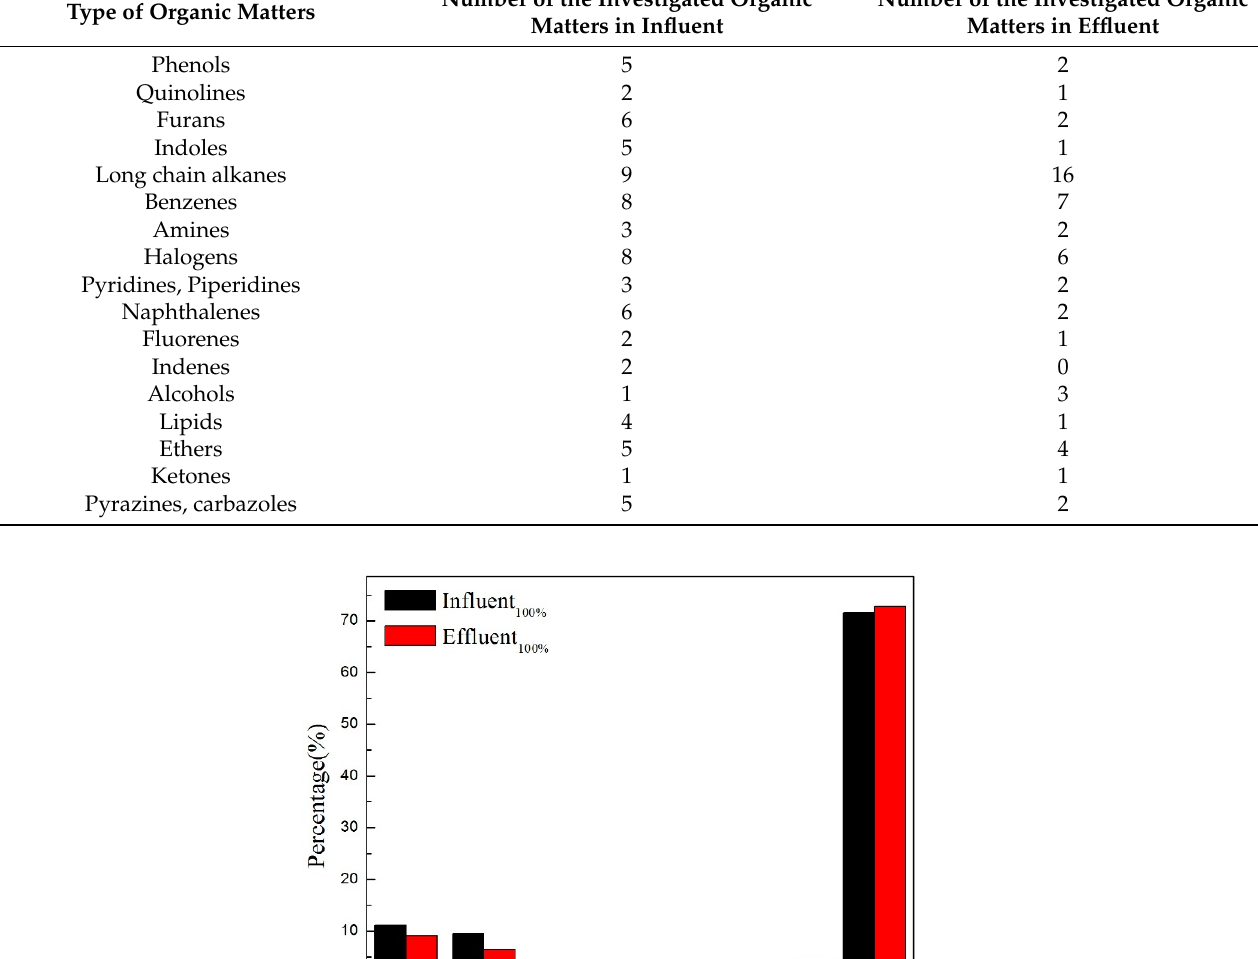
Table 3. GC-MS analysis results of the influent and effluent during acclimation.